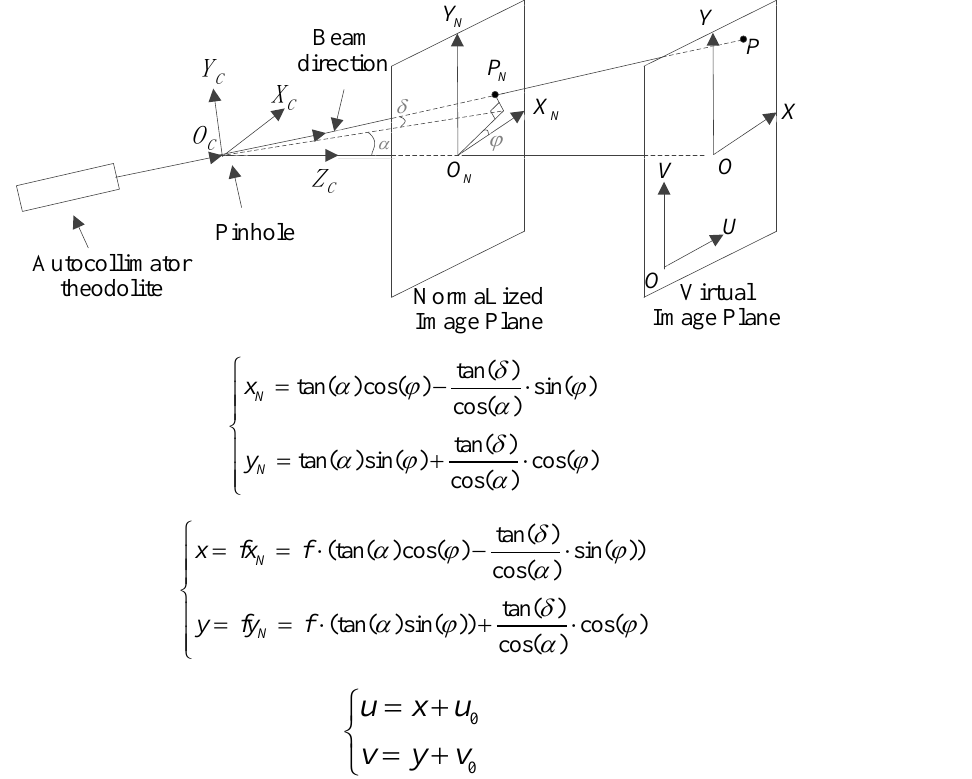
Figure 11. Coordinate systems in the ideal pinhole imaging